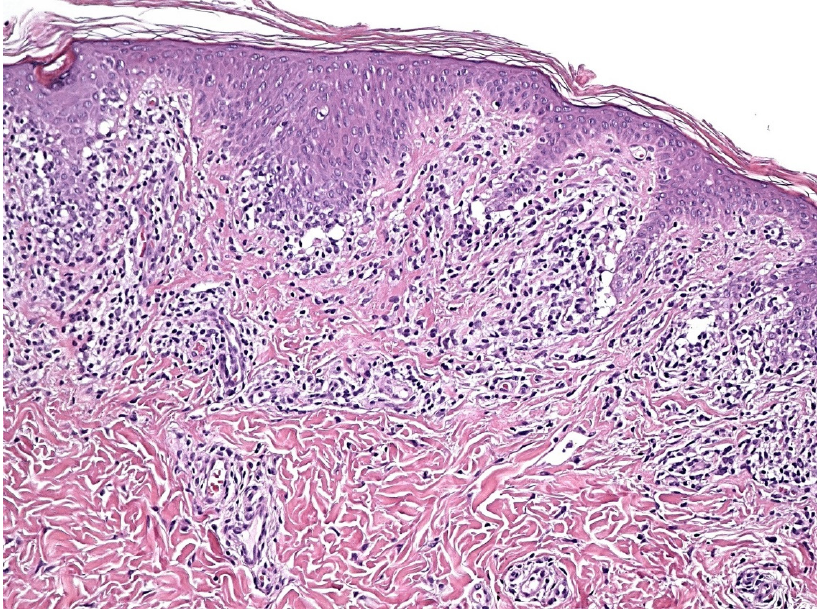
Figure 4. Histologically, early lesions show a lichenoid dermal infiltrate of lymphocytes at the tips of rete ridges, where vacuolar changes and some necrotic/apoptotic keratinocytes are seen at the dermo-epidermal junction. The horny layer has a basket-weave appearance, and the granular layer is normal.